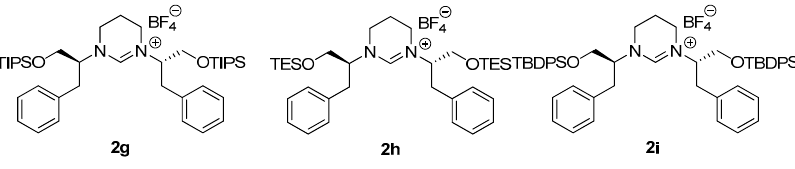
Figure 1. The structures of 2g – 2i .